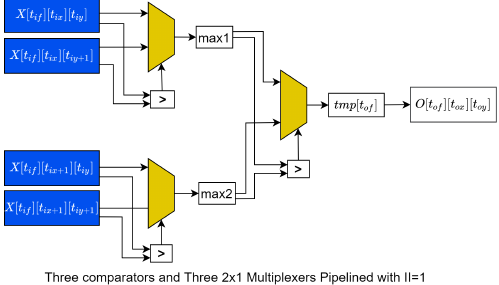
Figure 11. Max-pool